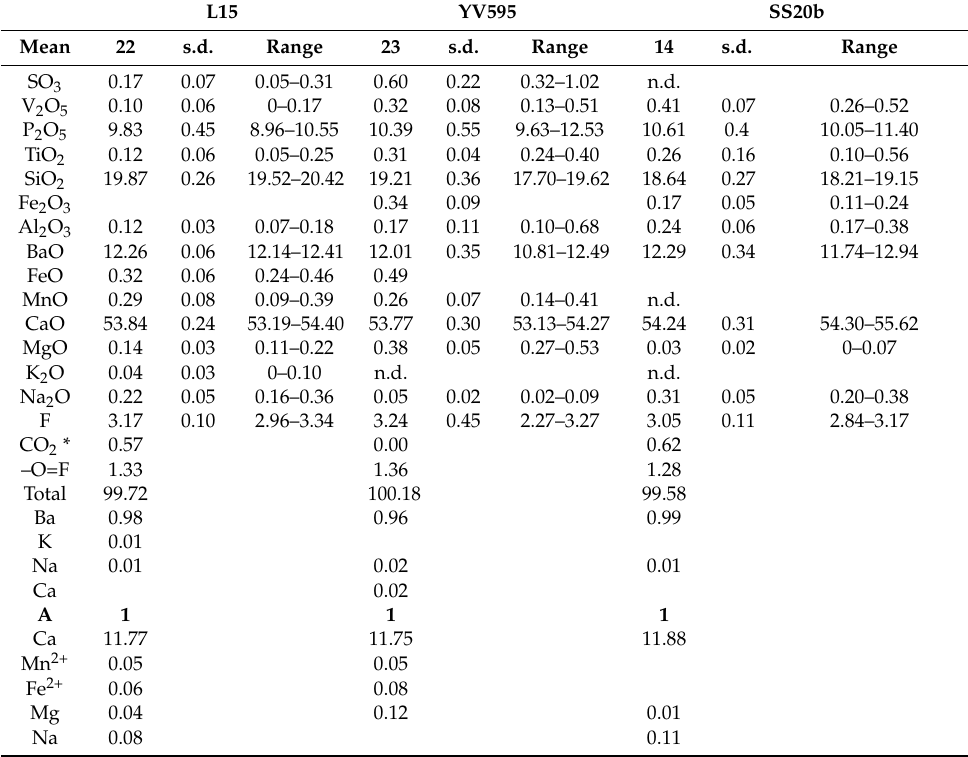
Table 1. Chemical composition of ariegilatite, wt